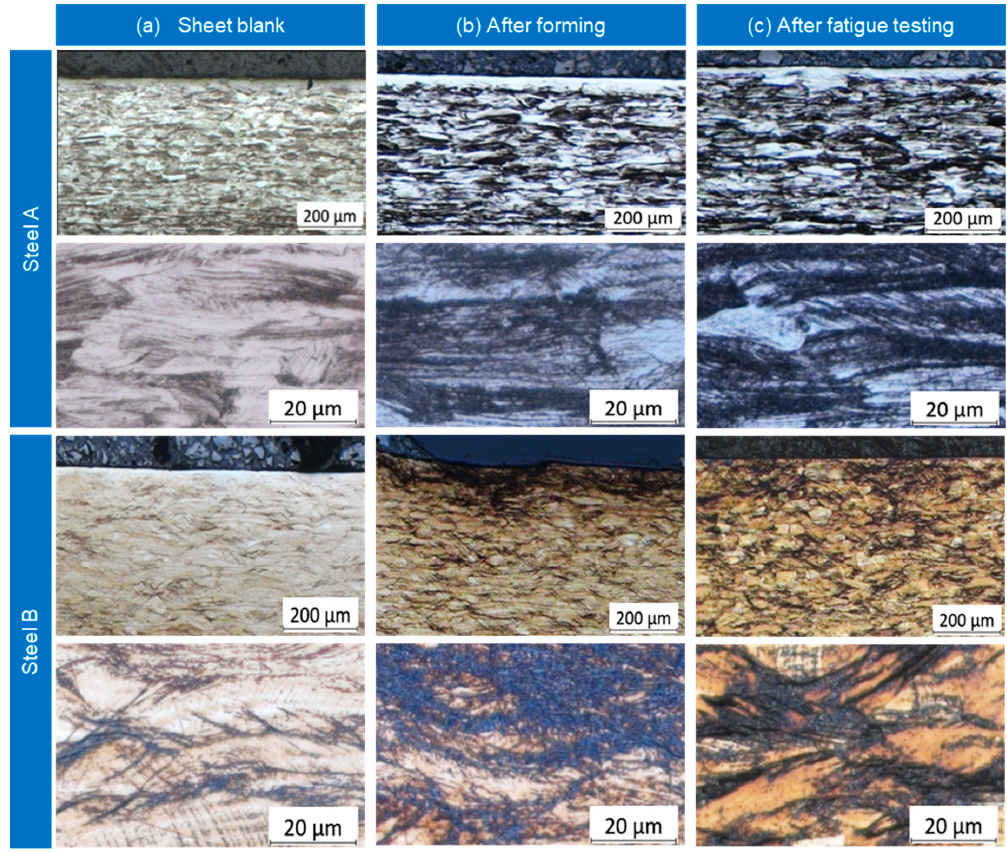
Figure 14. Micro-graphs of steel A and steel B cross-sections: ( a ) Sheet blank, ( b ) after forming, ( c ) after fatigue testing.